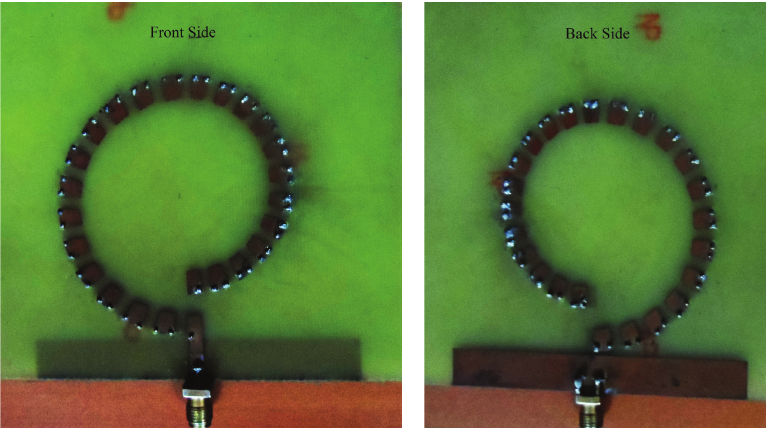
Figure 7: Prototype antenna.